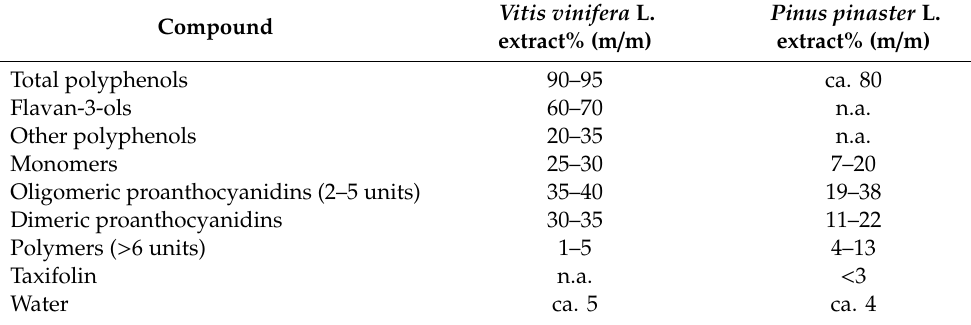
Table 1. Composition of test capsules containing 50:50 blend of extracts isolated from grape